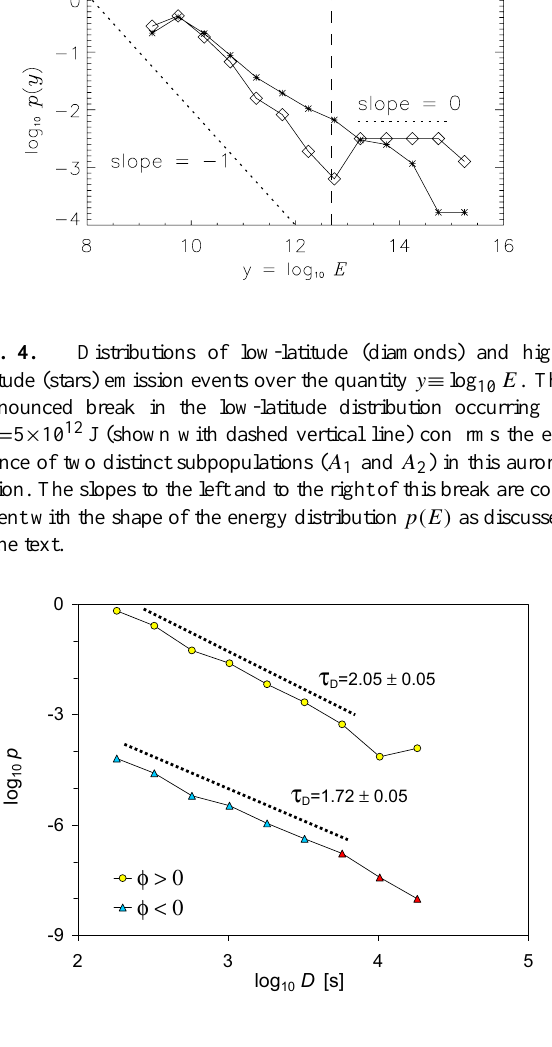
Fig. 5. Inter-trigger time distributions of low- and high-latitude events exhibiting distinct power-law slopes.